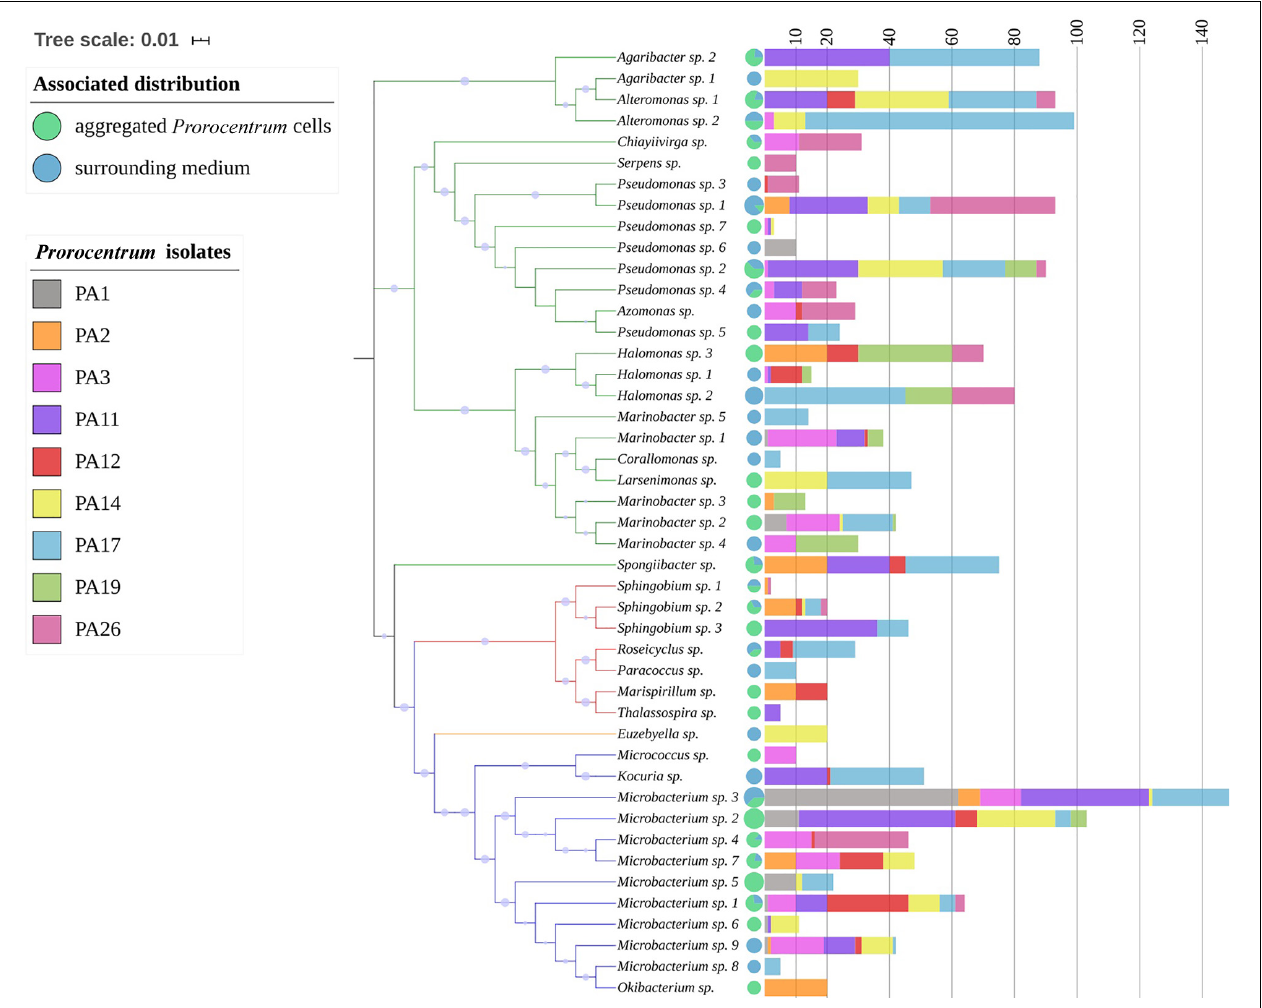
FIGURE 2 | Neighbor-joining phylogenetic tree of bacterial isolates from Prorocentrum cell cultures from the Veracruz Reef System and the Mexican Caribbean coast. The tree is constructed from 16S rRNA sequences with classification according to the Ribosomal Database Project, and with 10,000 bootstrap repetitions (blue dots). The tree scale indicates the evolutionary distance among the isolates. The branch color denotes the corresponding bacterial class: Actinobacteria (blue); Flavobacteriia (orange); α -Proteobacteria (red); γ -Proteobacteria (green). On the right, the pie charts show the proportion of colonies of each isolate associated with Prorocentrum cell aggregates (D) versus the surrounding culture medium (CM), whereas the colored stacked histogram bars (non-cumulative) indicate the number of colonies of each bacterial species (isolate) found in the nine Prorocentrum